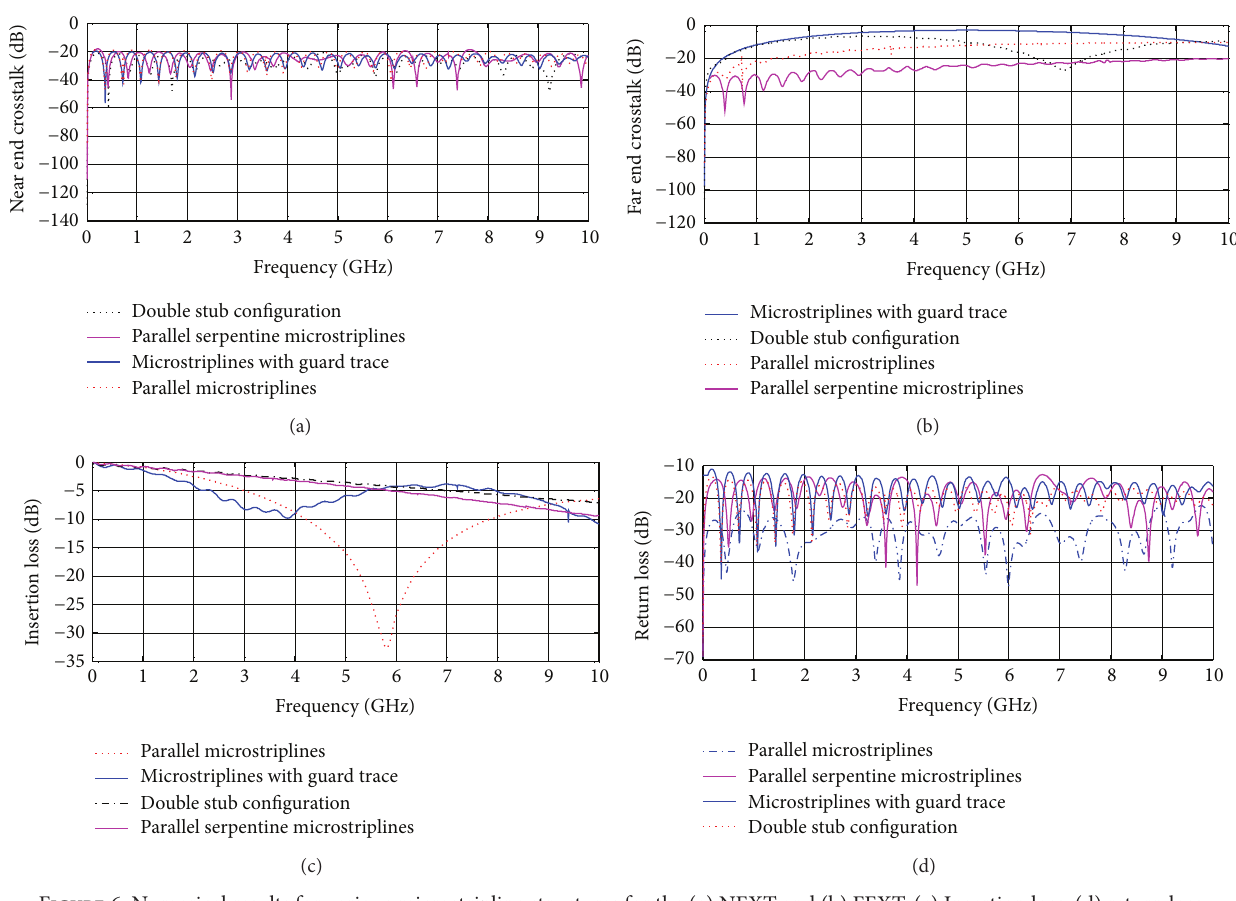
the convergence of the solution depended on the time and spatial parameters. The length of the structure was 8000 mils, whereas the width of the strip was 14 mils. Lines 1 and 2 had the same length and were separated by 19 mils, as depicted in Figure 2. The resistive voltage source was induced at port 𝑃 1 with a matching impedance of 50 Ω at both the source and